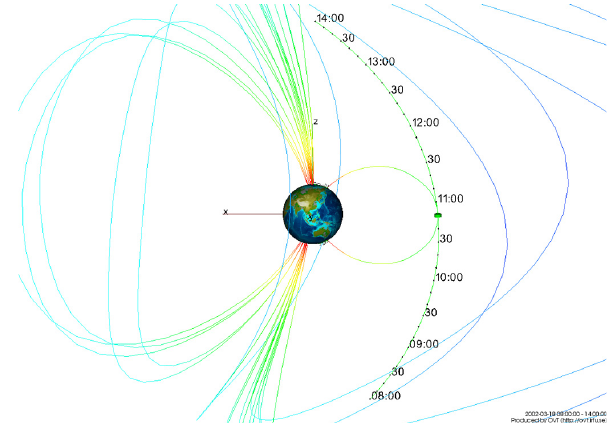
Fig. 2. Cluster C3 (spacecraft 3) orbit, in green, for the 18 March 2002 event, projected on the Tsyganenko (1989) mag- netic field model, GSE coordinate system. Orbit Visualization Tool plot, courtesy of the OVT